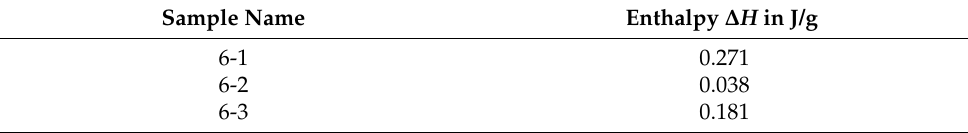
Table 2. Change in enthalpy of each sample.